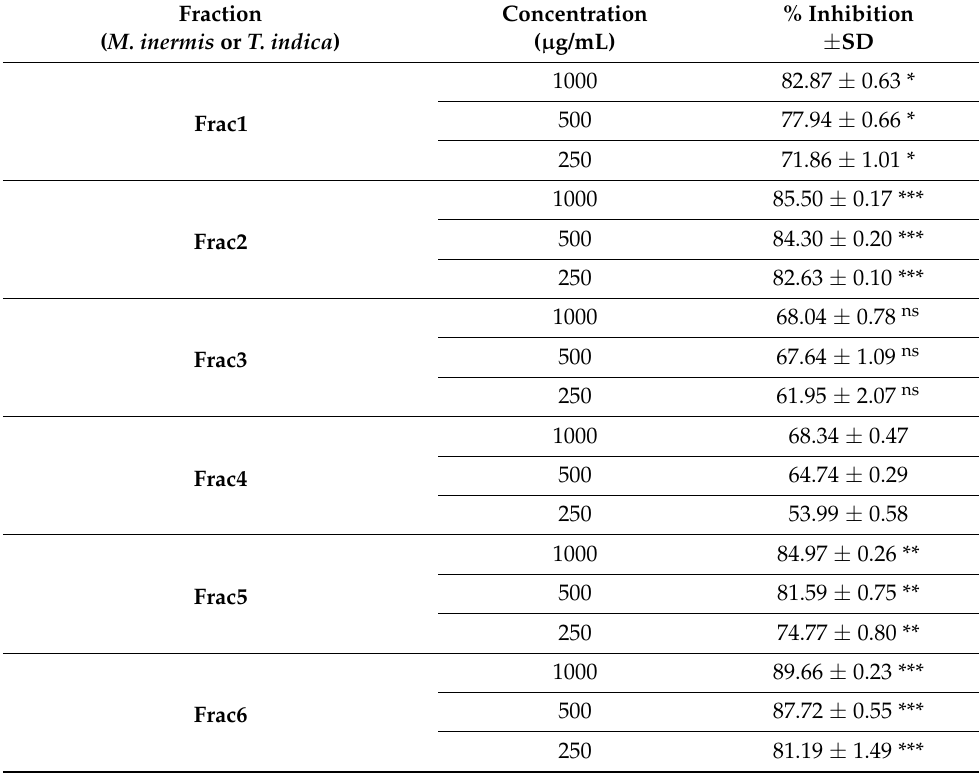
Table 1. In vitro anti-glycation activity of M. inermis and T. indica plant fractions.